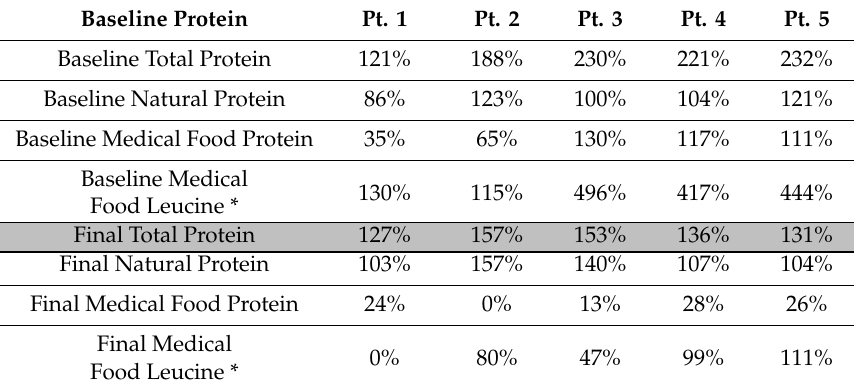
Table 2. Baseline diet to final diet change in relation to total protein intake, natural protein intake, and protein intake from precursor-free medical food, n = 5 patients (pt). Baseline